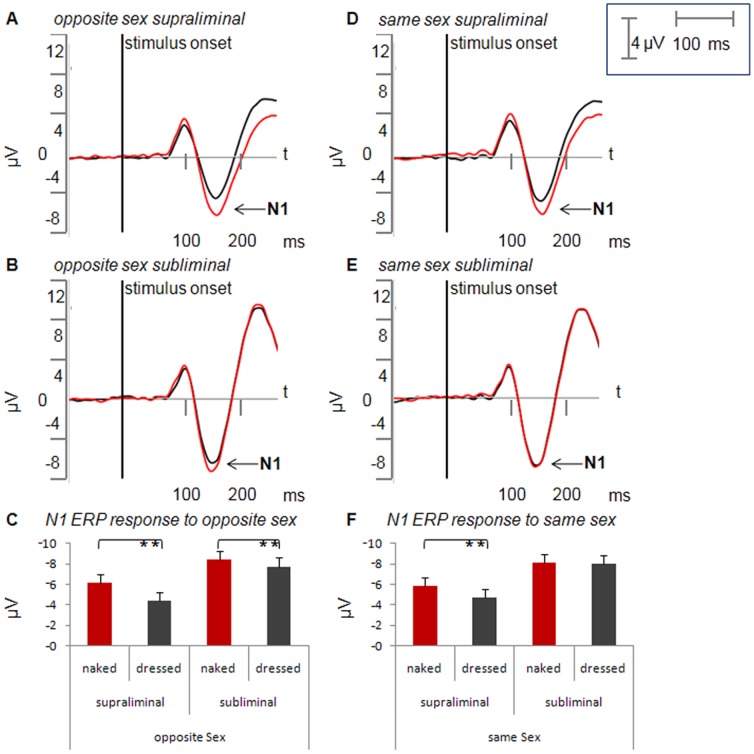
Average ERP for dressed and naked bodies in the supraliminal and subliminal conditions.Average ERP (in µV) for opposite-sex stimuli (A, B) and same-sex stimuli (D, E) for supraliminal and subliminal conditions. Naked bodies are indicated in red and dressed bodies in black. Arrow indicates the N1 component. Mean N1 values for opposite-sex stimuli in the different conditions are illustrated in the histogram below (C). N1 values for same sex stimuli are shown in (D). **p<.01, error bars indicate the standard error.